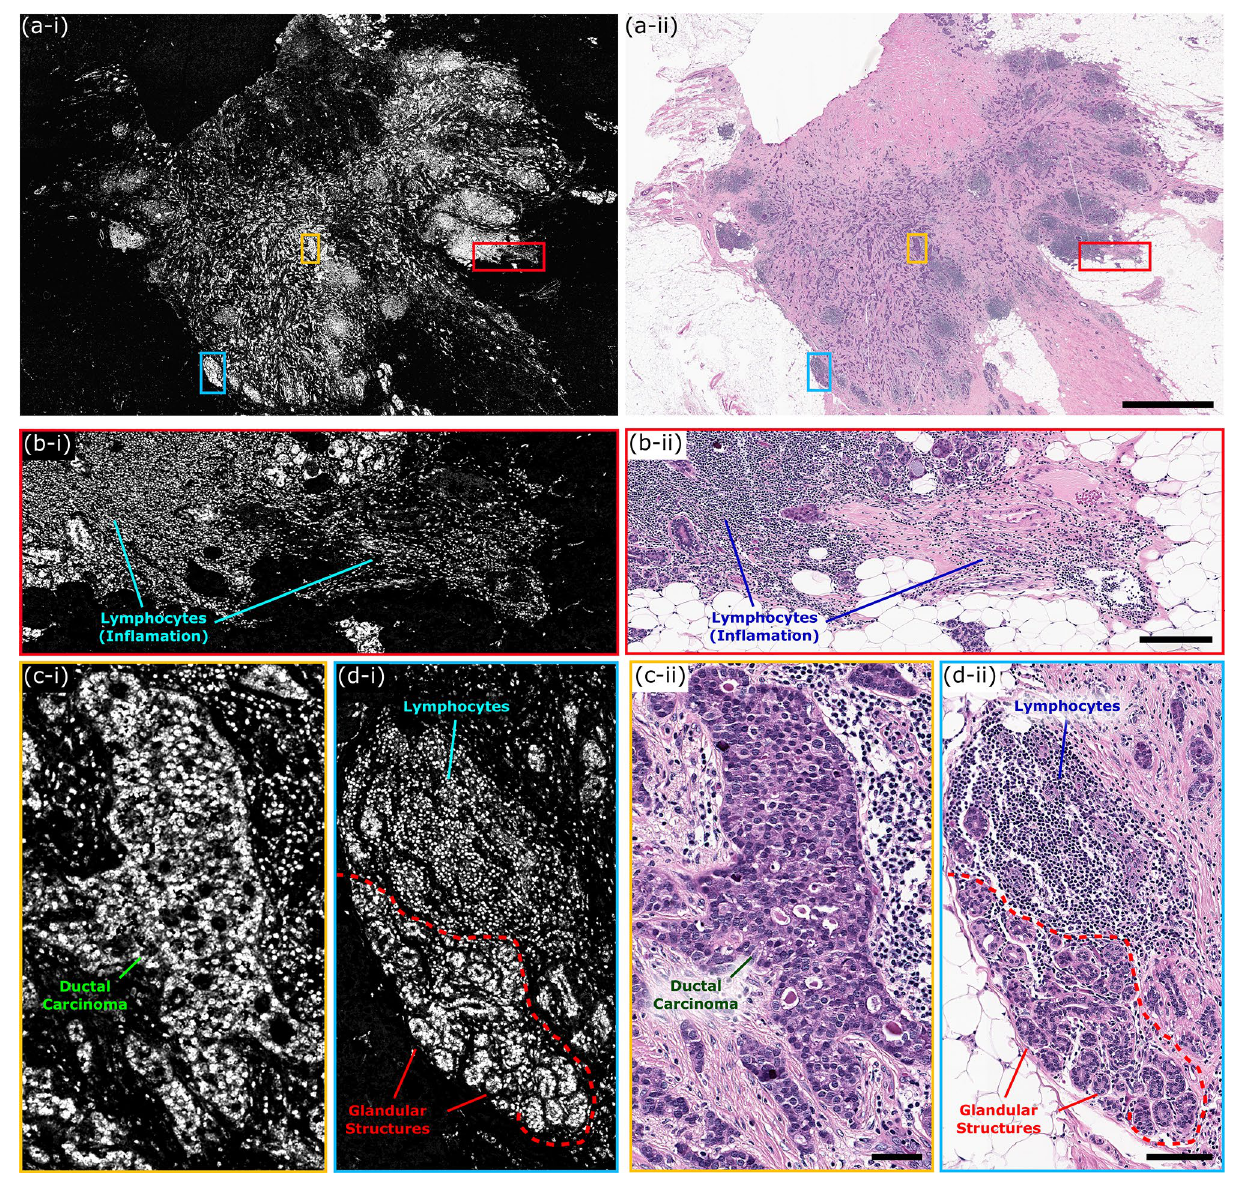
Figure 4. One to one comparison of PARS histological imaging and H&E staining. ( a ) Large field of view (9 mm × 13.25 mm) PARS (780 megapixel) image of nuclear morphology in a thin section of formalin fixed paraffin embedded excised breast tumor tissues. ( b – d ) ( i ) Subsections of the large field of view PARS image ( a ) highlighting regions of interest within the large field scan. ( ii ) Images of the exact same set of tissues following H&E staining, providing a direct one-to-one comparison between PARS imaging of tissues and the gold standard for histopathology H&E imaging. ( a ) Scale Bar: 2 mm. ( b ) Scale Bar: 200 µm. ( c ) Scale Bar: 50 µm. ( d ) Scale Bar: 75